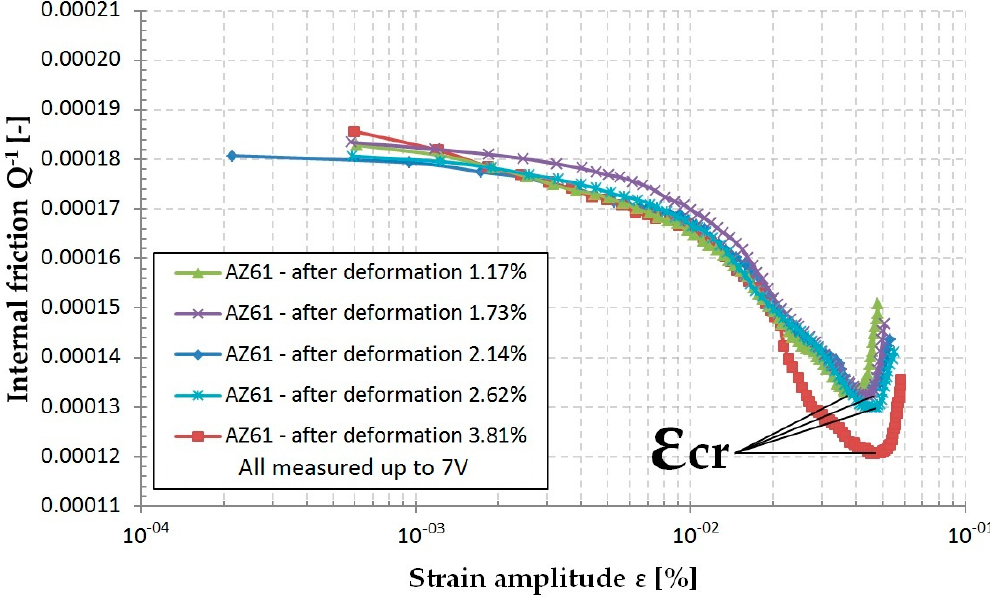
Figure 14. Amplitude dependent internal friction measured for the predeformed AZ61 alloy.